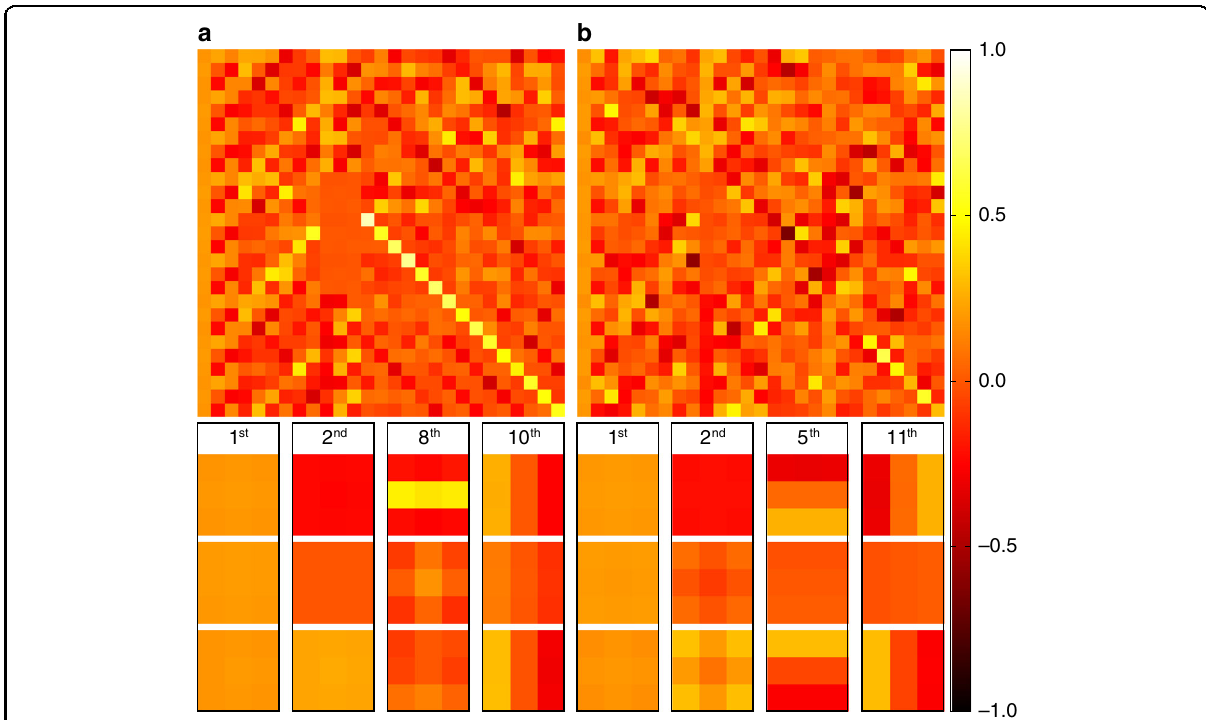
Fig. 15 The spatial dictionaries learned from the instances of the letter T and the pyramid. The spatial dictionary learned from the instance of the letter T is shown in a . The spatial dictionary learned from the instance of the pyramid is shown in b . For the letter T, the fi rst atom captures the low-frequency pattern of the local patches. The second, eighth, and tenth atoms capture the local structures of the object in three directions. For the instance of the pyramid, the dictionary atoms provide an accurate representation of the four faces. These two dictionaries differ signi fi cantly and can be used in further tasks like recognition and classi fi